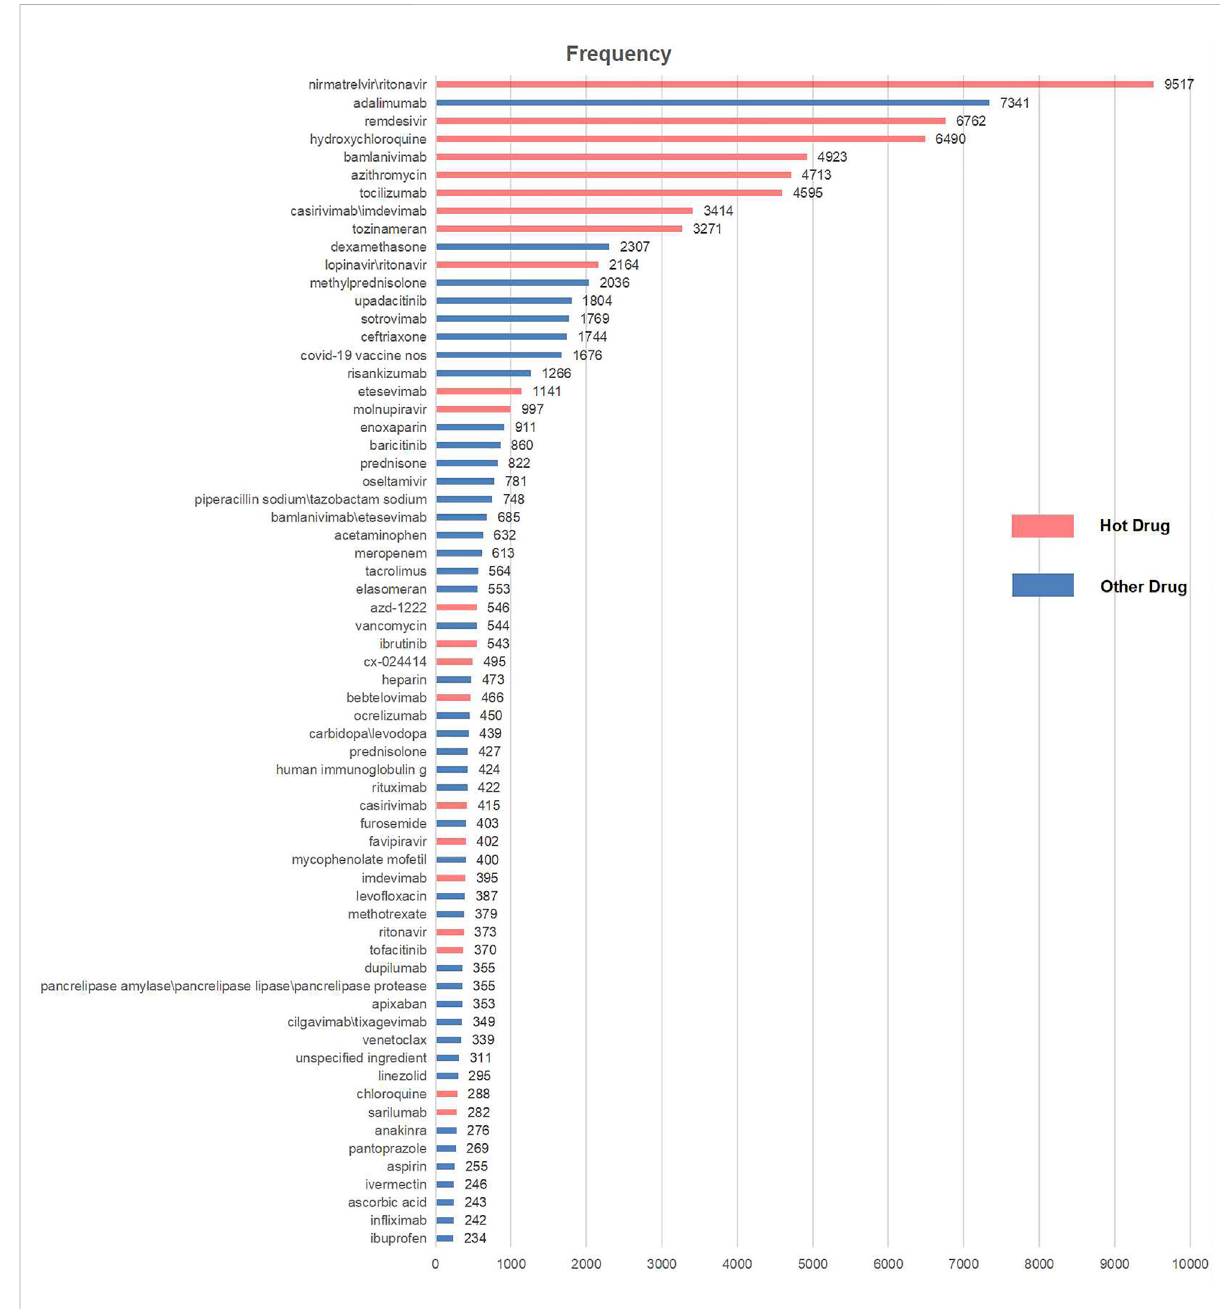
FIGURE 1 Frequencies of frequent drugs in the COVID-19